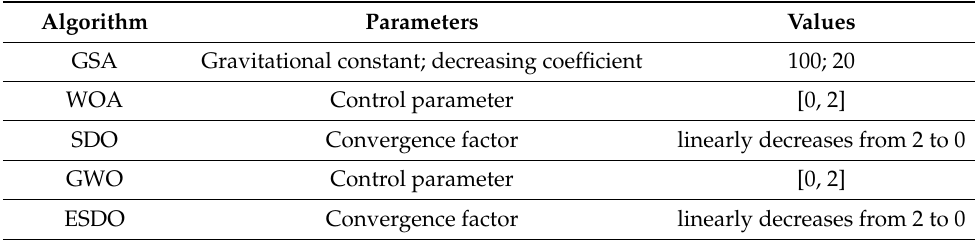
Table 1. Parameter setting of each